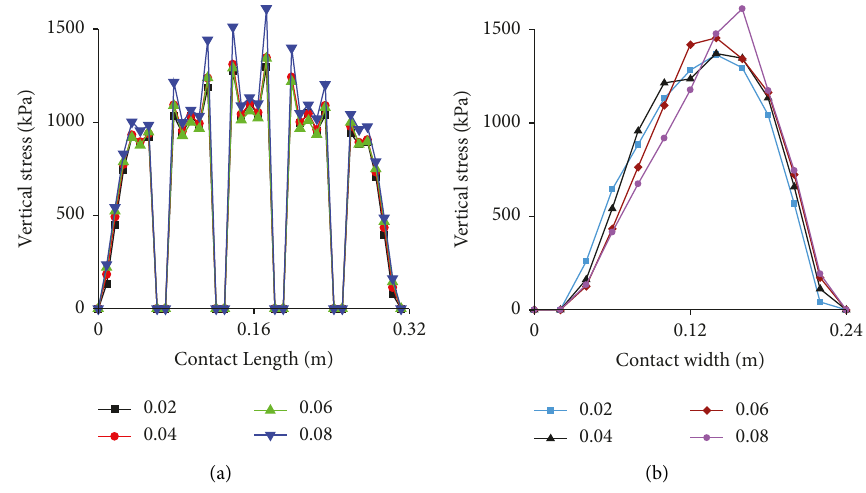
Figure 15: Vertical stress under different slip rates: (a) width and (b) length.